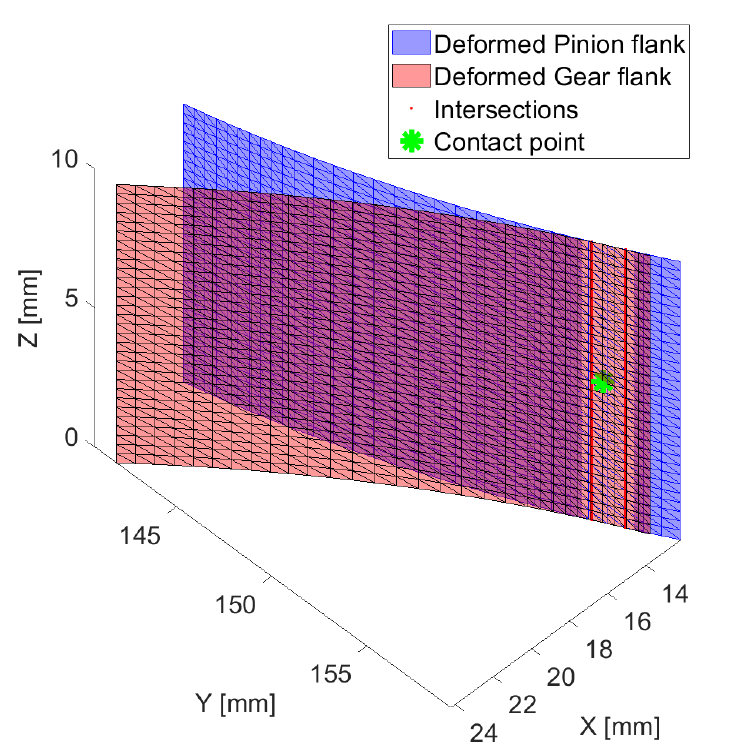
Figure 3. Surface intersection between two engaging teeth and location of the contact point at equilibrium after